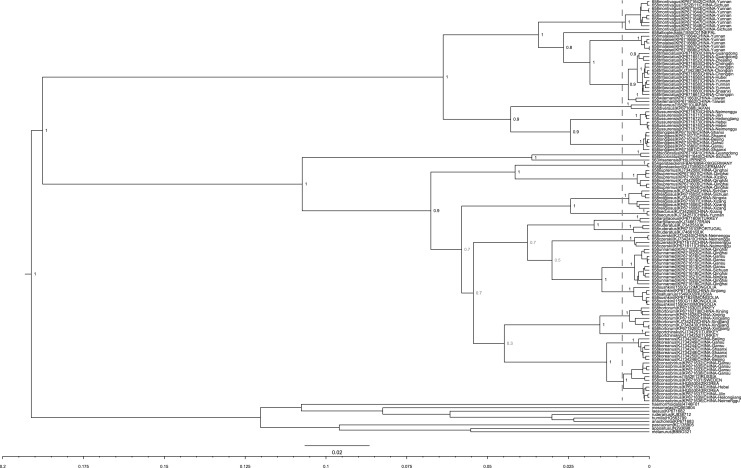
GMYC analysis to recognise species of Megabombus.Values at the nodes are Bayesian posterior probabilities for groups (values <0.8 are shown in grey). The scale bar represents 0.02 substitutions per nucleotide site. The single threshold of GMYC model result is shown by the vertical grey bar. Each tip is labelled with: the length of COI barcode sample sequence; the taxon name; the GenBank or BOLD ID; the sample COUNTRY and for larger countries, province.